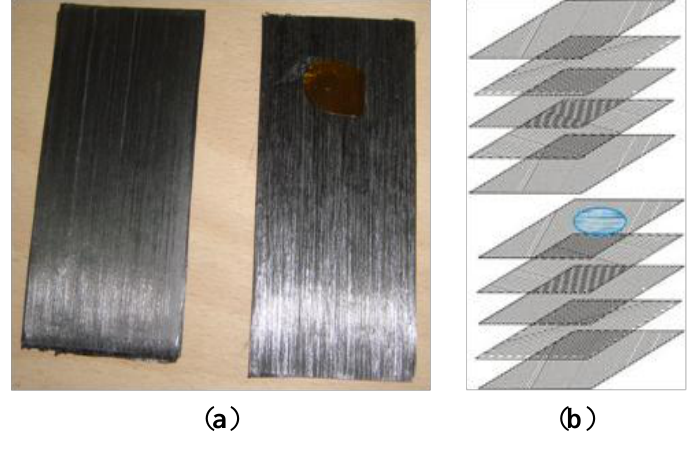
Figure 2. Prepreg laminas and the position of the Kapton disk. The photo on the ( a) shows the position of the Kapton disk over unidirectional fibers. The sketch on the (b) shows the position of the insert on one half of the lamina in the middle of the stacking